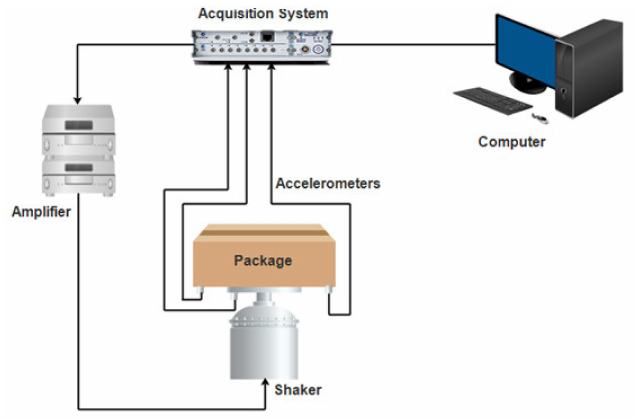
Figure 11. Schematic diagram showing a packaging simulation setup [131]. Reprinted with permis- sion.